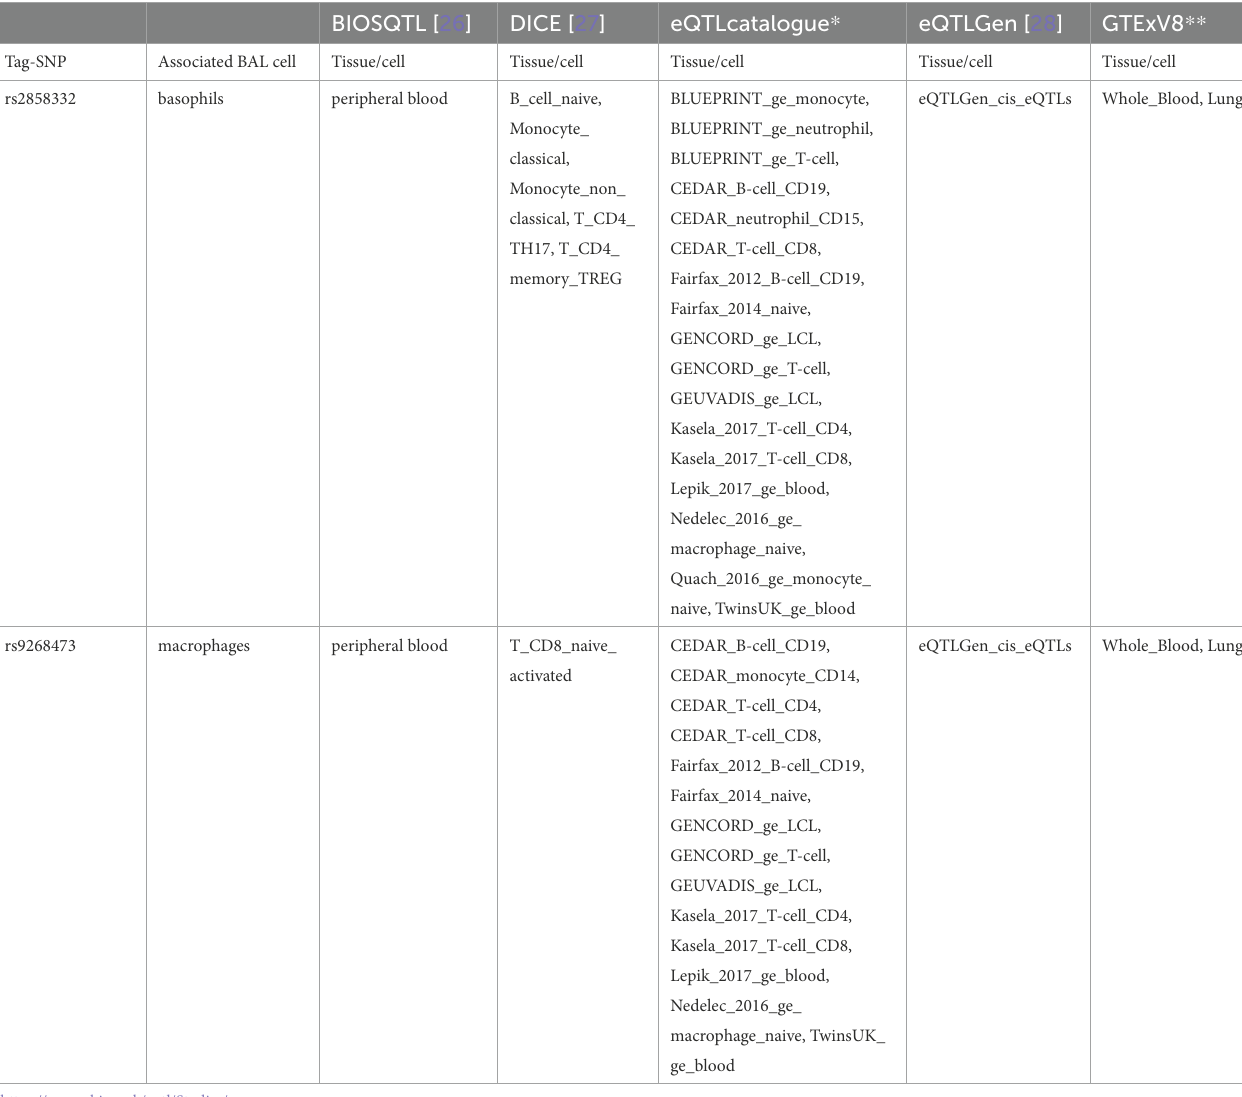
TABLE 6 Top non-LS tag-SNPs associated with BAL cell types identified as eQTL